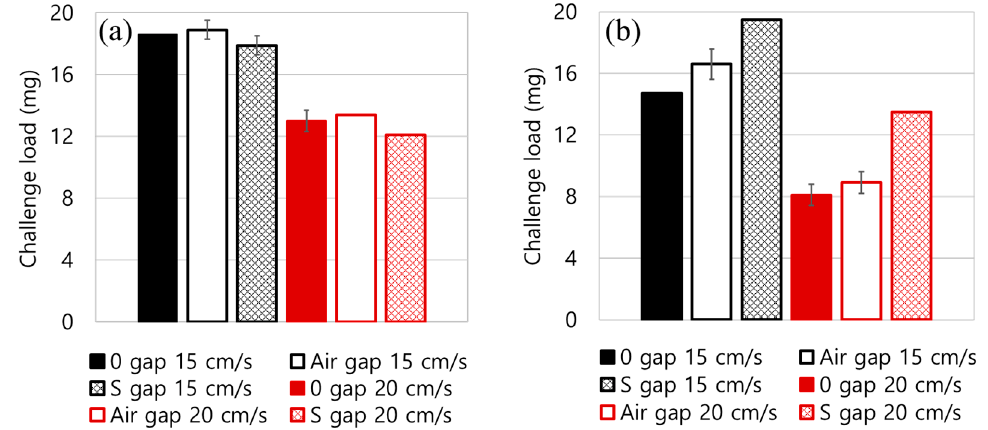
Figure 6. Service life associated with the pressure drop for different layer constructions. ( a ) Challenged load at 50 mm H 2 O for 2-layer construction, ( b ) Challenged load at 50 mm H 2 O for 4-layer construction.